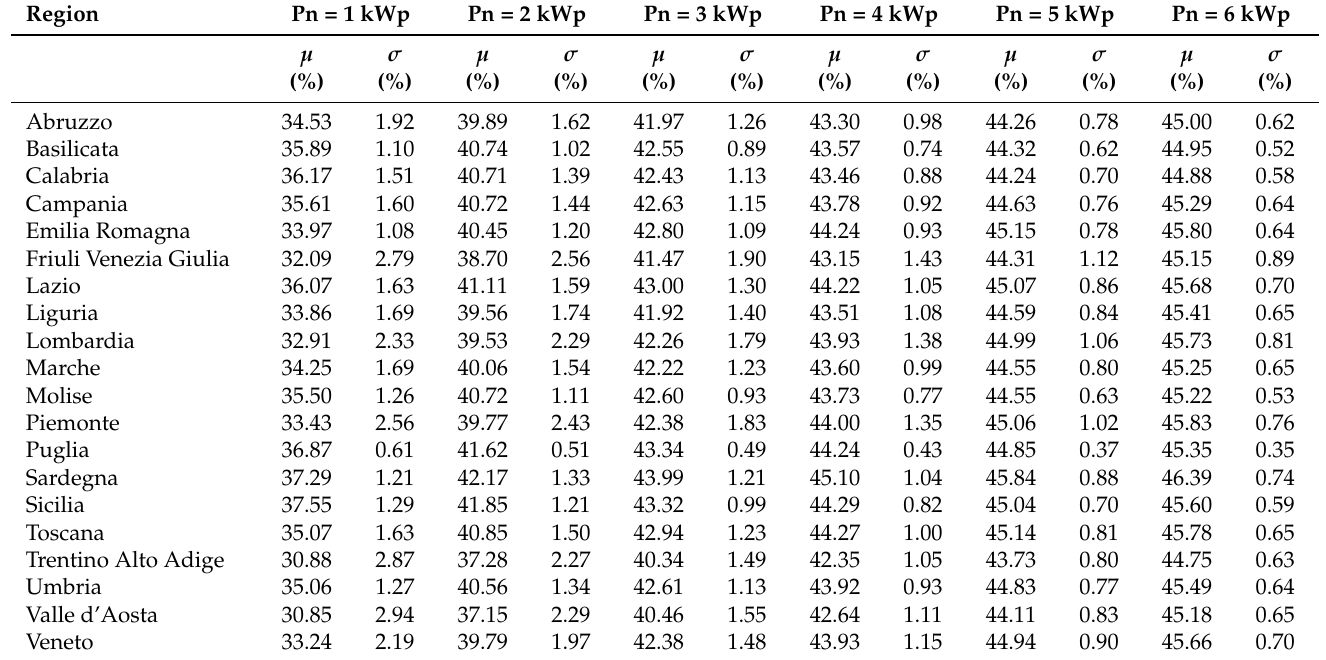
Table 5. Self-Sufficiency for E L = 2700 kWh without battery.